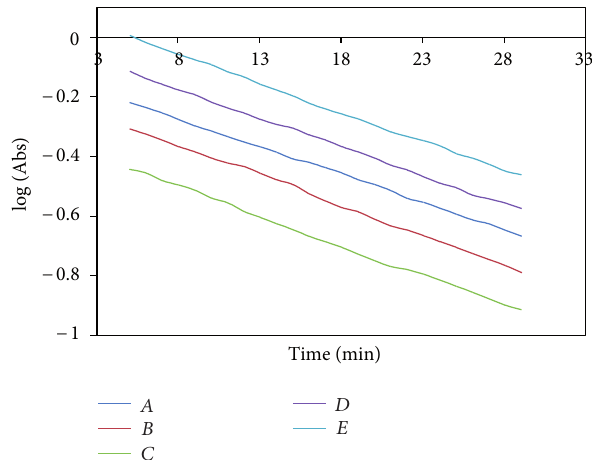
F 1: First-order plots of the oxidation of Aspartic acid by per- manganate in aqueous alkaline medium. [Asp] =